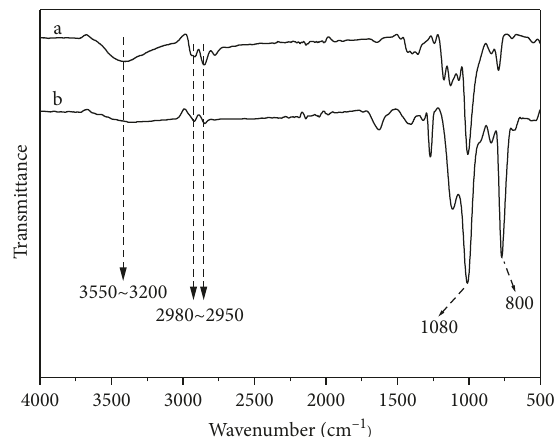
Figure 5: FTIR spectra of pure PVA sponge (a) and the silylated PVA sponge (b).